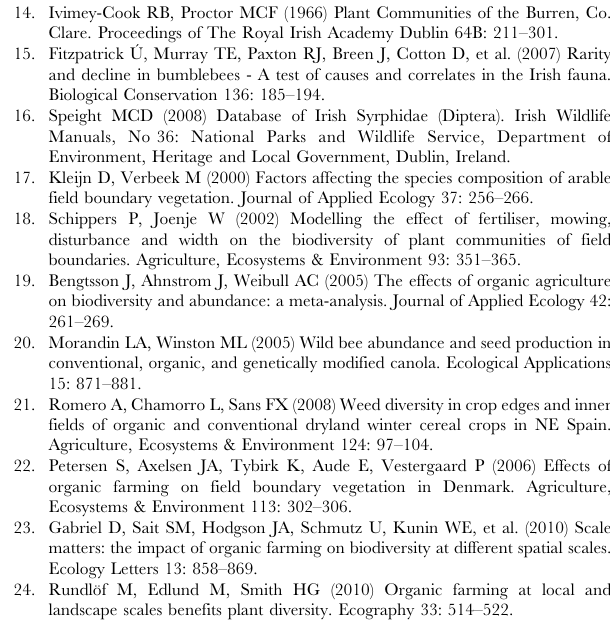
Table S1 Mean ± standard error soil parameters measured in organic and conventional field edges and centres. Table S2 List of all insect-pollinated forbs, non-insect pollinated forbs and graminoids and associated mean recorded in the edges and centres of organic and conventional dairy fields. Table S3 Relationships between soil parameters and farm type (organic/conventional), position in the field (edge/centre) and the interaction between farm type and edge/centre. Table S4 Mean ± standard error hedgerow area, hedgerow length and number of connections between hedgerows within 1 km radii of organic and convention- al